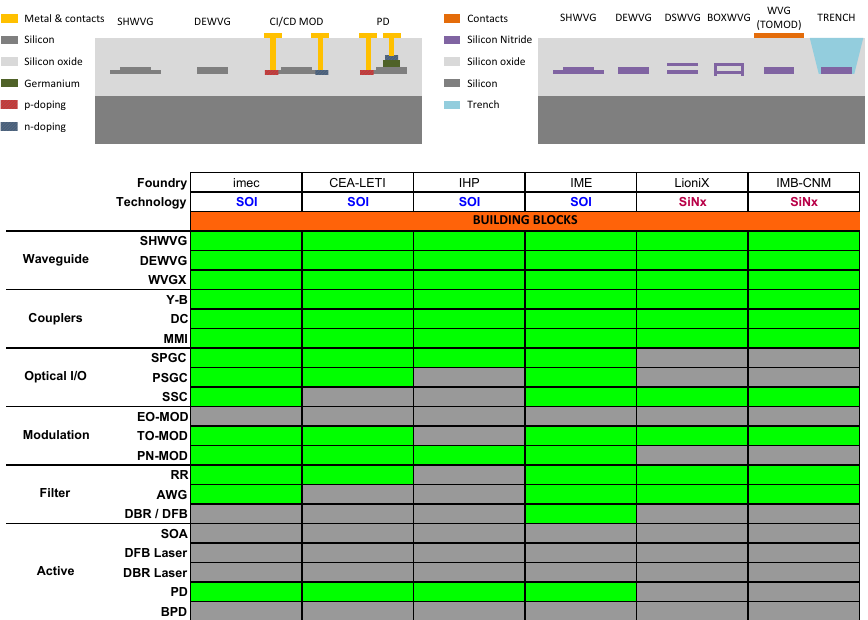
Figure 2. Silicon photonics platform cross-sections (top) and building blocks per foundry (bottom). Color code: Green = Available/Possible, Grey = Not Available/Possible. Abbreviations: SHWVG Shallow waveguide, DEWVG Deeply etched waveguide, DSWVG double-stripe waveguide, WVGX Waveguide crossing, Y-B Y-branch, DC Directional coupler, MMI Multi-Mode Interference coupler, SPGC Single Polarization Grating Coupler, PSGC Polarization Splitting GC, SSC Spot-Size Converter, EO-MOD Electro-Optic Modulator, TO-MOD Thermo-Optic Modulator, PN-MOD PN Junction Modulator, RR Ring Resonator, AWG Arrayed Waveguide Grating, DBR Distributed Bragg Reflector, SOA Semiconductor Optical Amplifier, PD Photo-Detector, BPD Balanced